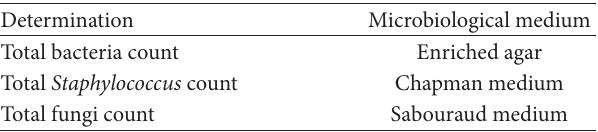
Table 2: Microbiological media used for the microbiological evalu- ation of eggs and